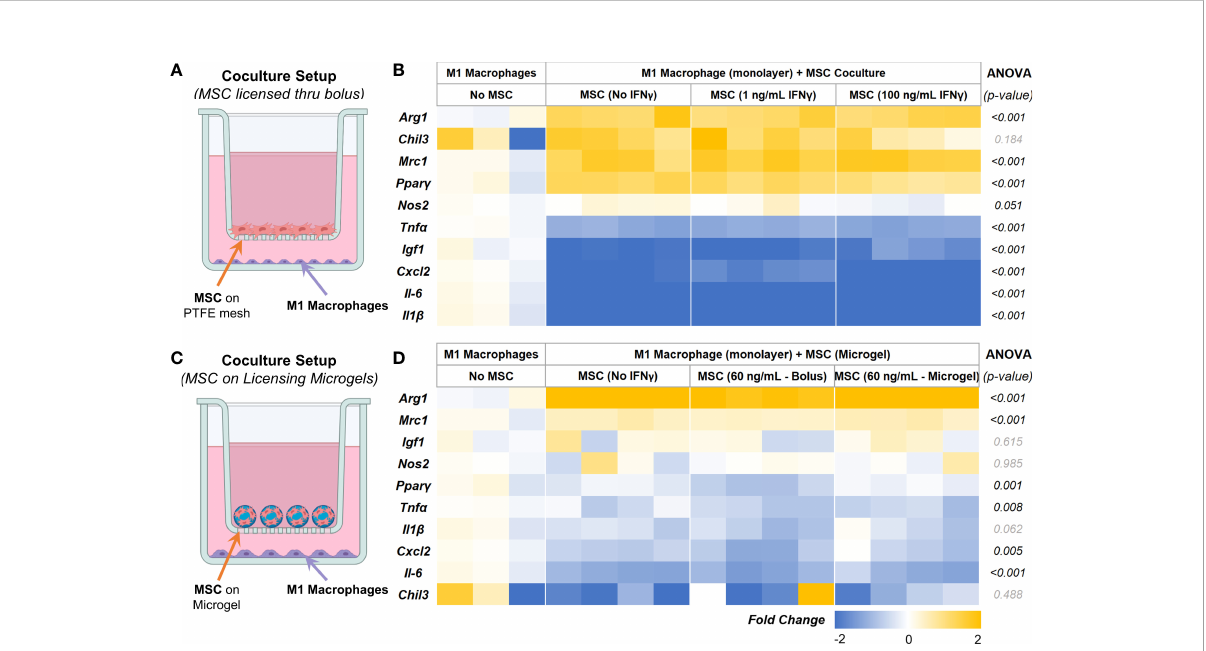
FIGURE 7 AD-MSC and M1 Macrophage Cocultures. (A) Schematic of the co-culture setup to evaluate the MSC paracrine effects on M1-like macrophages. (B) Heatmap showing the expression levels of proin fl ammatory and prohealing genes by macrophages after 24 hours of co-culture with licensed AD-MSC. (C) Schematic of the co-culture setup showing AD-MSC seeded on microgels in the trans-well and M1 macrophages on the bottom well. (D) Heatmap showing the expressional levels of proin fl ammatory and prohealing genes by macrophages after 24 hours of co- culture with AD-MSC on microgels. All fold changes are with respect to the housekeeping gene, Gapdh, and quiescent control AD-MSC.